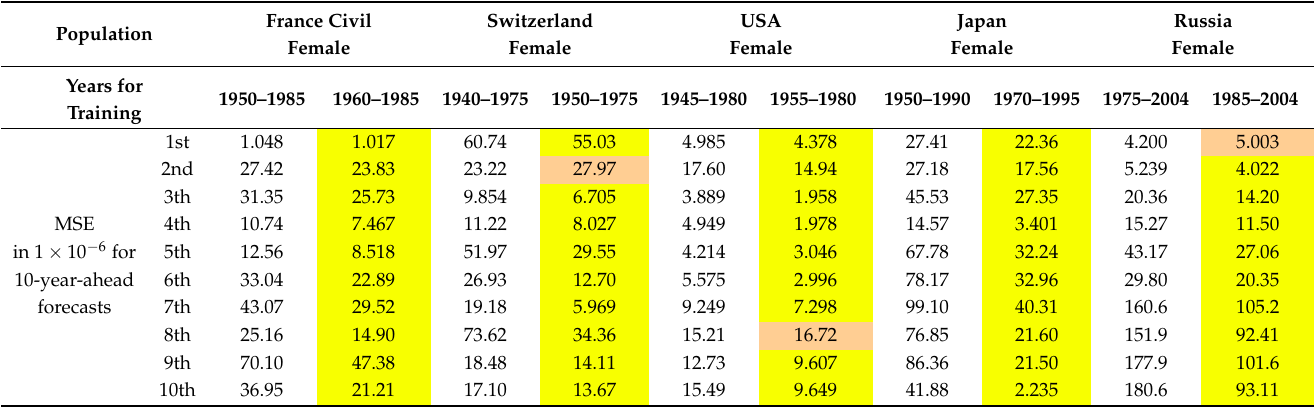
Table 10. DLGC 10-year-ahead forecasts’ accuracy is improved by fitting chosen